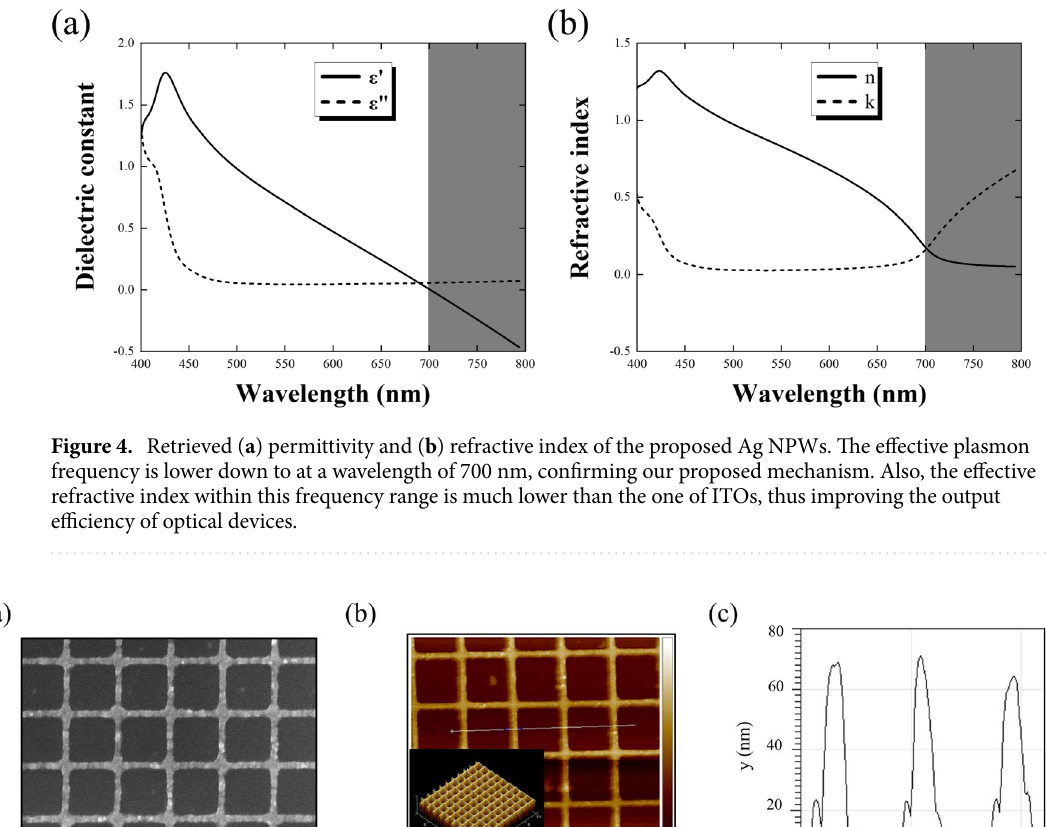
Following the promising optimized results from the Ag NPWs, we have learned that the designs of the Ag- NPW TCE with the best FoMs are p/w/t = 400/50/70 nm for both blue and green colors, and 450/50/70 nm for red color, respectively. We thus fabricated these TCEs accordingly and, meanwhile, a TCE with the dimensional parameters of 500/50/70 nm as a comparison to examine the effect of removing first-order diffraction. Figure 5a shows the morphology observation of the fabricated Ag NPWs with the p/w/t of 400, 50, and 70 nm. From the SEM image, the fabricated metal wires are all well-connected to each other without any breaks around joints, which secure a better sheet resistance. Moreover, the topography and line profile of the samples measured via atomic force microscopy was included in Fig. 5b,c, indicating excellent homogeneity of the as-fabricated sample with an average thickness of 71.3 nm. As shown in Fig. 6a, all the measurement results show excellent averaged transmittance of 86.2%, 86.8%, and 86.1%. A minor deviation of slightly lower transmittance was due to rough metal surface and blue-shifted LSPR mode. The measured average transmittance for different periodicities indi- cates that removing the first-order diffraction greatly enhanced the transmittance in the blue light region. We can find out that Ag NPWs with a periodicity of 400 nm deliver the best blue light transmittance with 88.0%, whereas the ones with a periodicity of 500 nm only deliver blue light transmittance with 81.6%. As for the regime at a longer wavelength, the cutoff of the guided mode suppresses the transmittance of the Ag-NPW with a periodicity of 400 nm as previously discussed, thus contributing to the lowest transmittance (84.3%) at the red light regime. Taking a step further, we also fabricated the Ag NPWs with different linewidths for the periodicity of 400 nm as shown in Fig. 6b. From the transmittance spectra of the NPWs, the LSPR modes are obviously observed and blue- shifted with respect to the decreasing linewidth, experimentally evidencing that by manipulating the linewidth of the NPWs, we could remove the LSPR modes from the visible regime, thus enhancing the average transmit- tance. Finally, the transmittance of the 35- and 70-nm-thick ITOs is also measured. As depicted in Fig. 6c, the larger thickness of the ITOs results in lower transmittance. Conversely, the corresponding sheet resistances of these three Ag NPWs exhibit 8.18, 9.77, and 10.83 Ω/sq, respectively. Based on the two measurement results, we tabulated the corresponding transmittance and sheet resistance in Table 3 and calculated FoMs in Table 4 for each color. In each light regime, the parameters with the best FoM are according to the optimized simulation result. Although the FoMs are lower than the simulation result that might be due to the deteriorated transmittance,